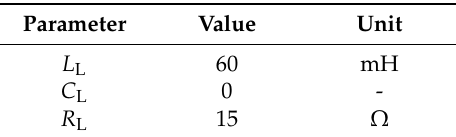
Table 1. Parameters of the rectified